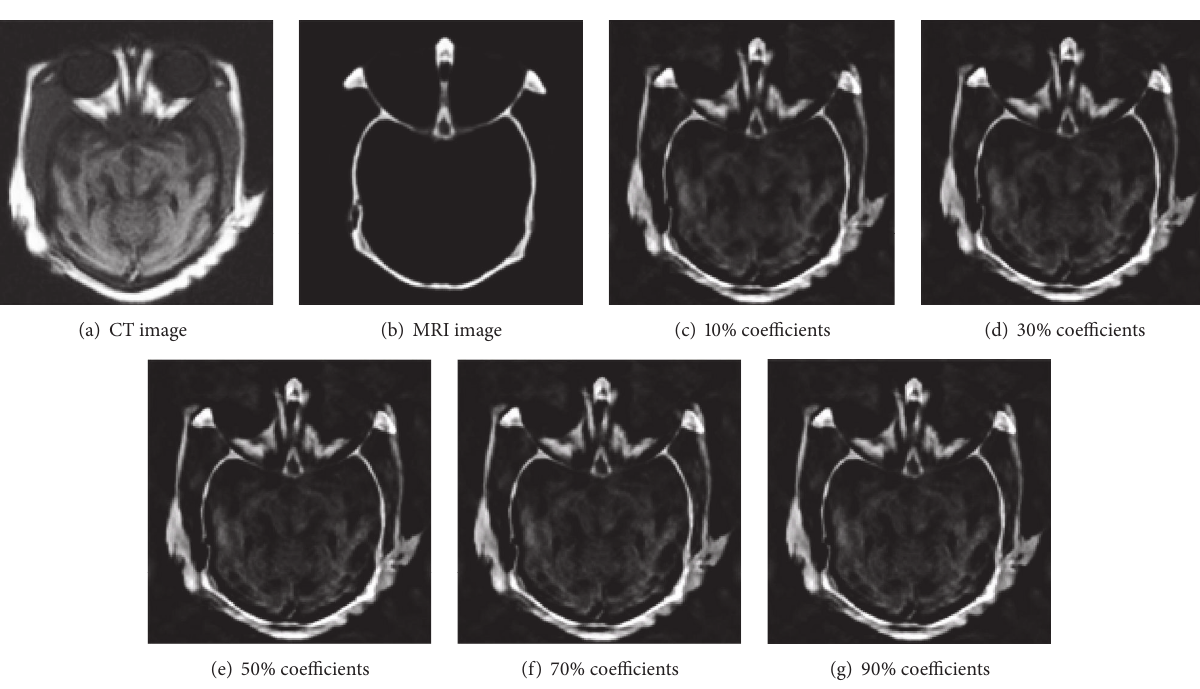
Figure 2: Fusion of contourlet nonlinear